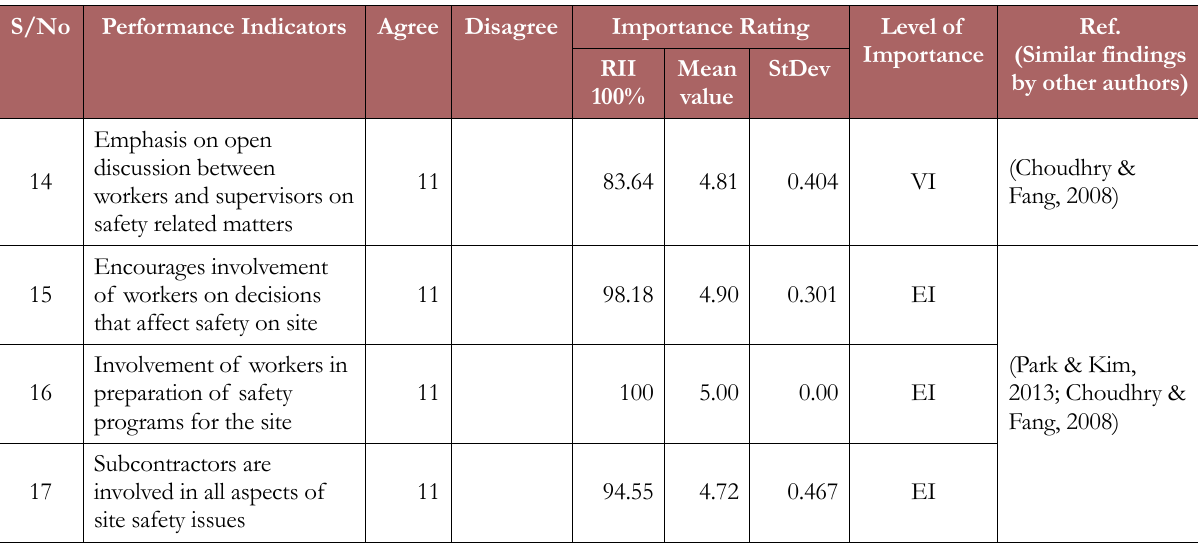
Table 6. Key Performance Indicators for Management Effort and